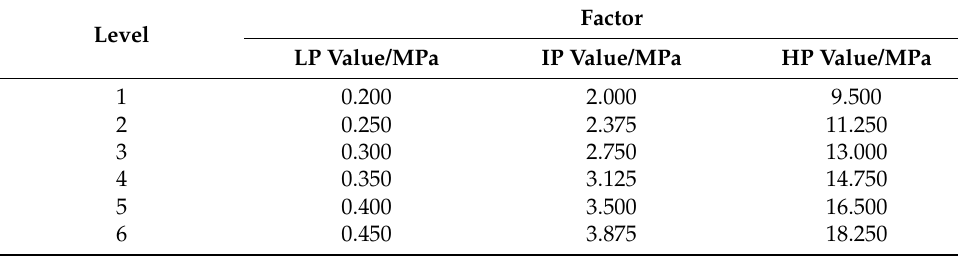
Table 4. Factor level table about the influence on the power generation cost of CCGT.